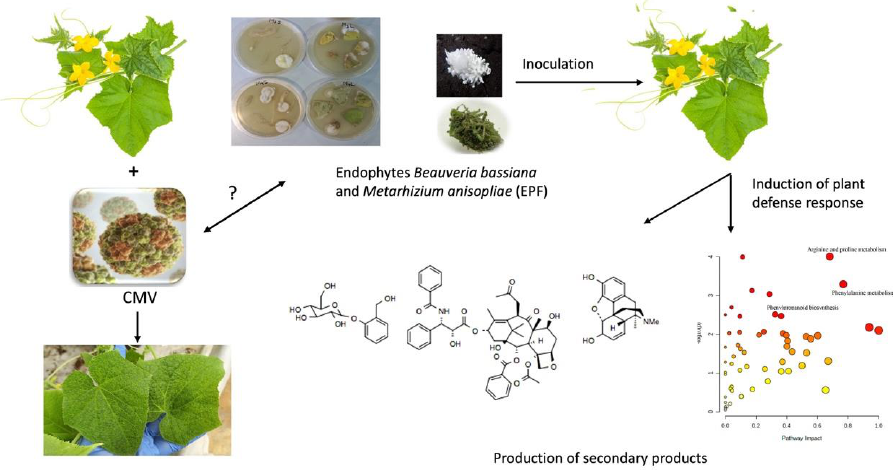
Figure 13. Metabolomic interaction between plant–fungal endophyte–virus revealed 631 differentially expressed metabolites of various pathways.